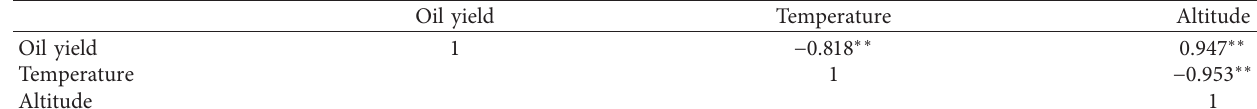
Table 4: Correlation between oil yield, altitude, and temperature of the cultivation sites.